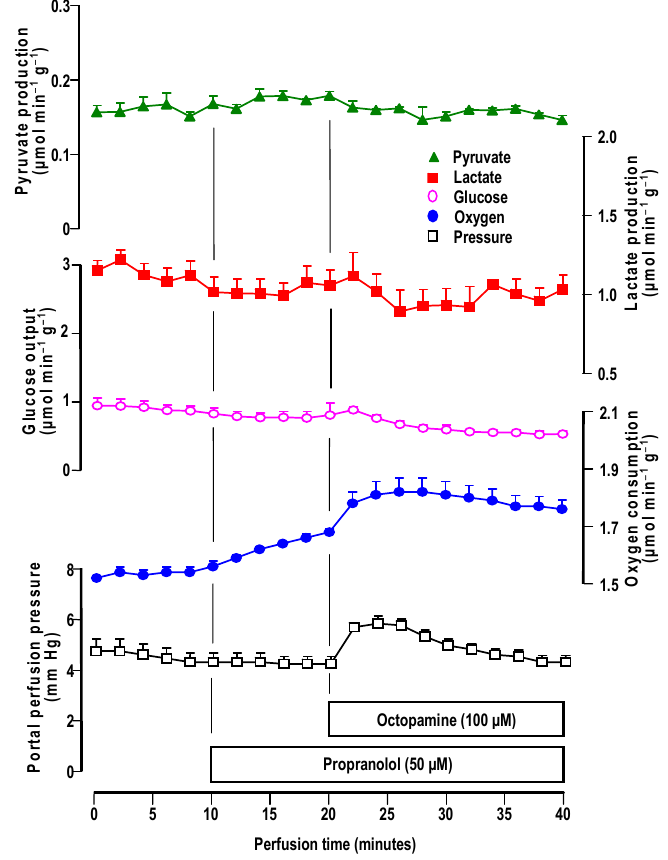
Figure 5. Influence of propranolol on the metabolic and hemodynamic effects of octopamine in livers from fed rats. Livers were perfused as described in materials and methods. The experimental protocols and the portal concentrations of propranolol and octopamine are indicated by the bars just above the time scale. Datum points are means ± mean standard errors of 5 liver perfusion